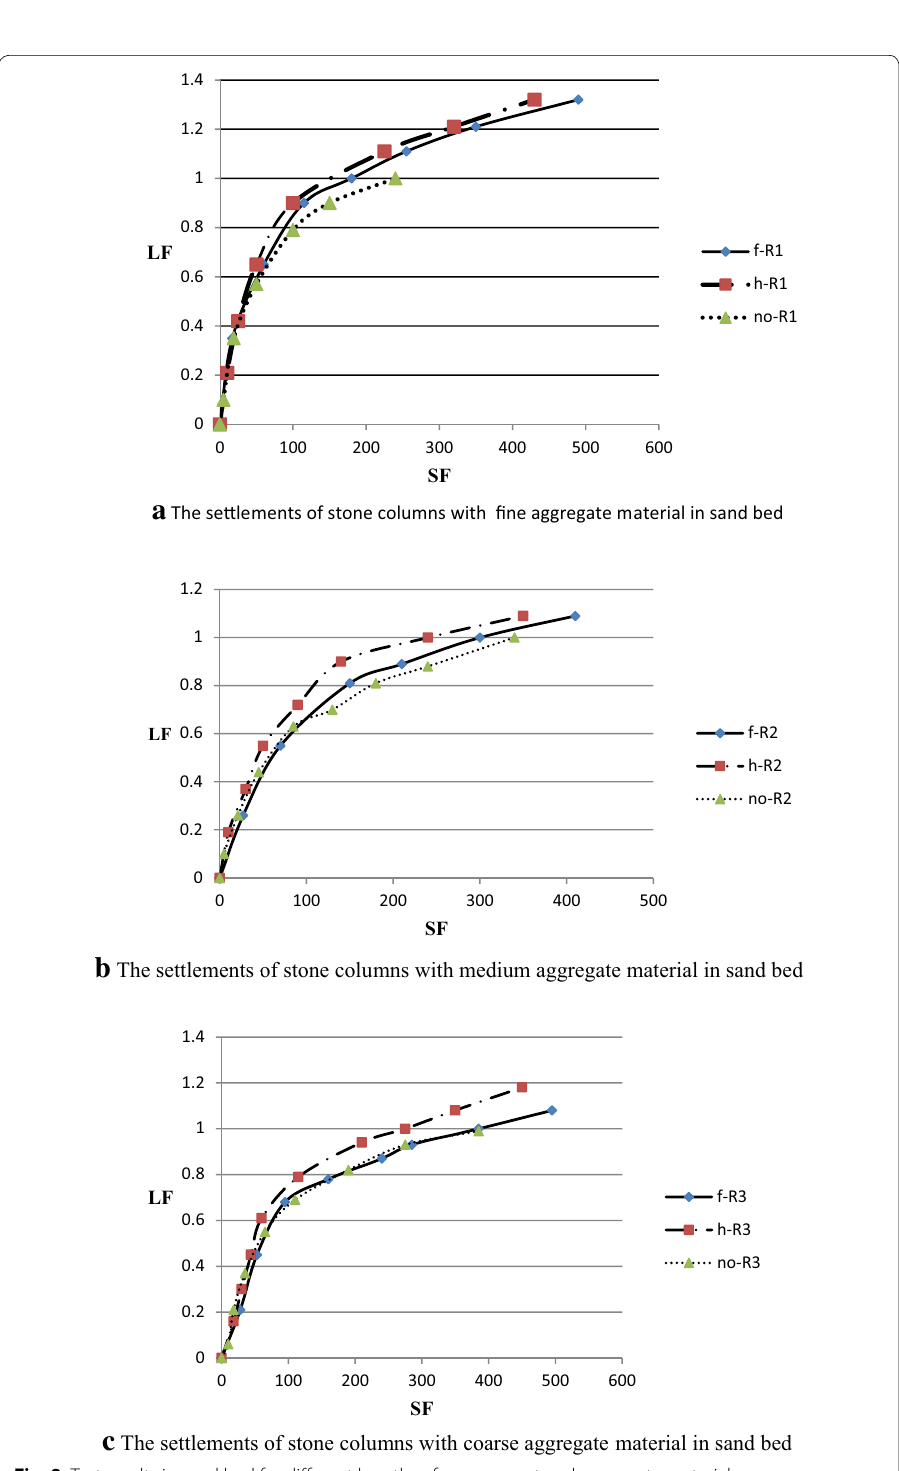
Fig. 8 Test results in sand bed for different lengths of encasement and aggregate